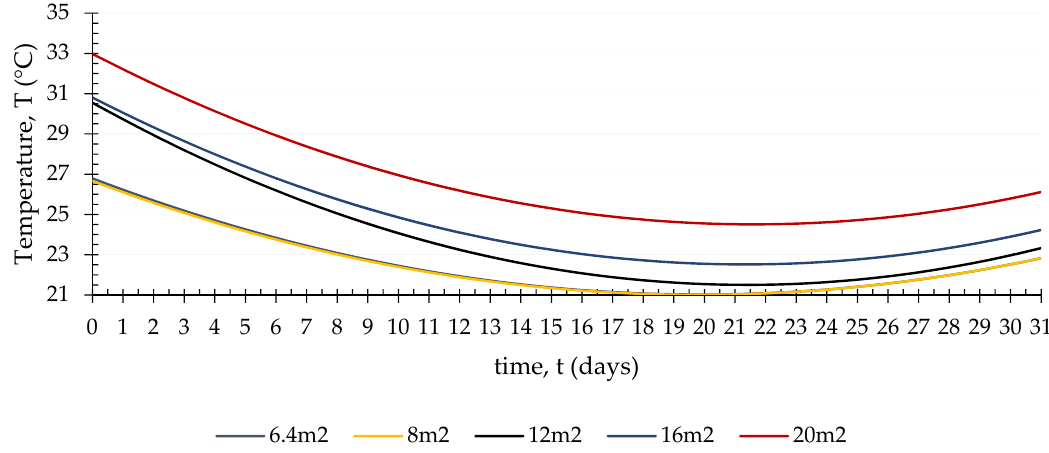
Figure 7. Average TES temperature with different solar collectors’ area with full heating load exchanged (parabolic model) for January.